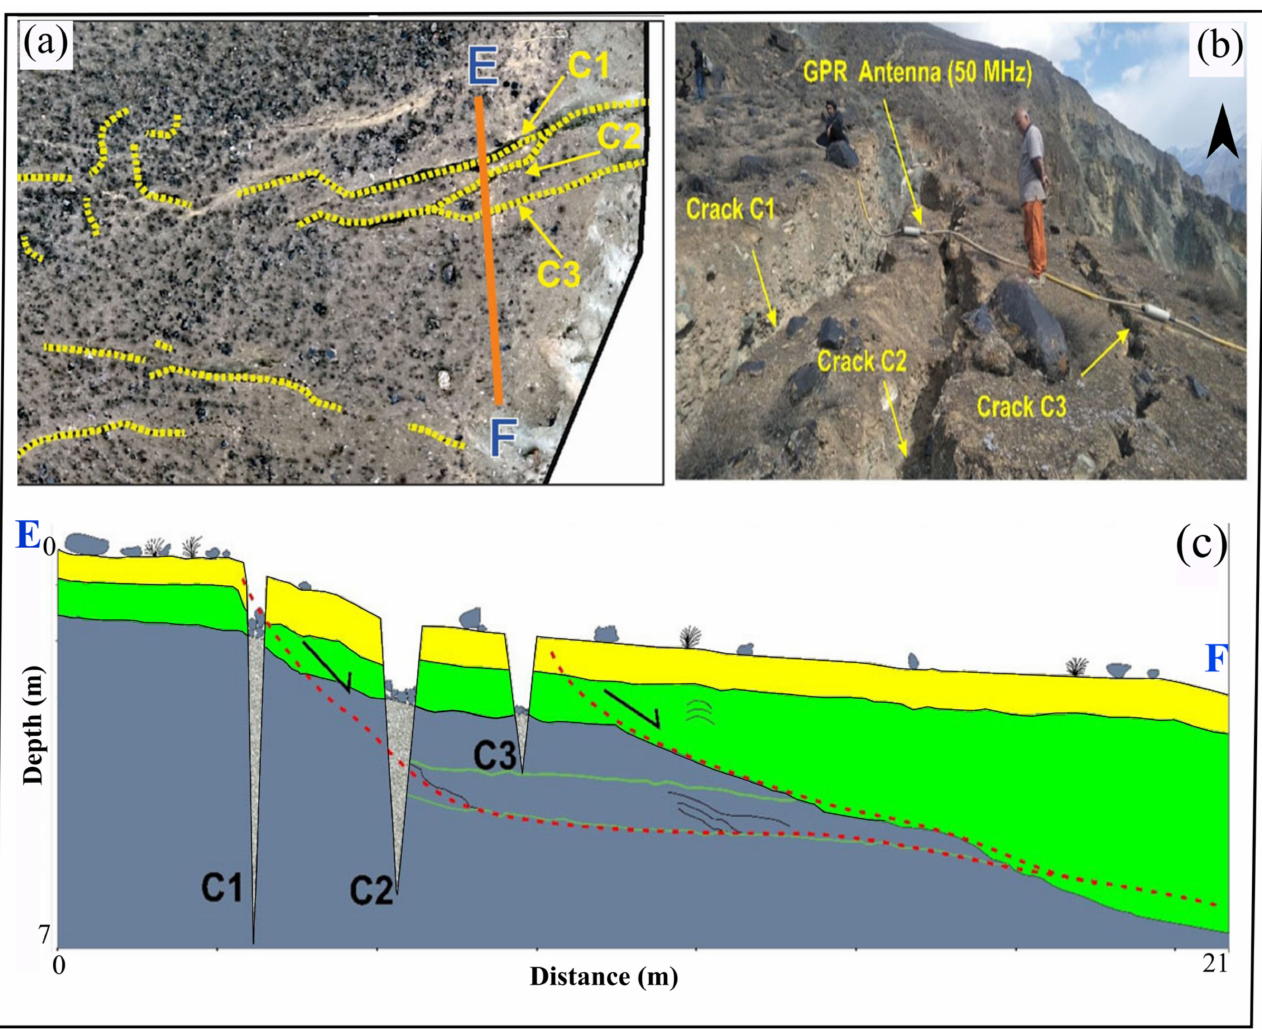
Figure 8. ( a ) GPR profile (EF), ( b ) zoomed photograph and ( c ) a cross-section of landslide architecture derived from UAV and GPR integrated application from a landslide in Pakistan. C1, C2, and C3 denote the cracks; red dotted lines and black solid represent landslide slip surfaces and joint systems, respectively (from ref.